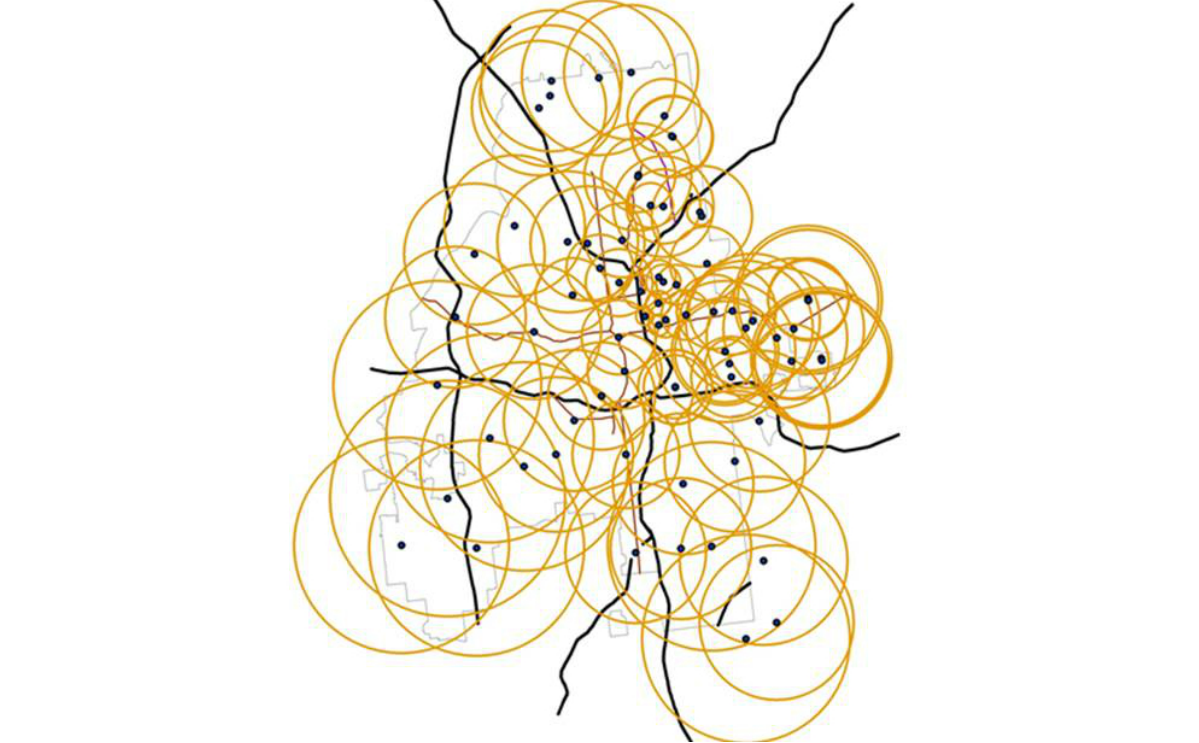
Figure 4. Map of Atlanta showing 79 data collection points from profiles on a sex-seeking networking app; radii of yellow circles represent distance to user sample at the maximum distance from the sample point, and overlapping circles completely cover Atlanta, with smaller circular areas used for data collection where there were the largest numbers of application